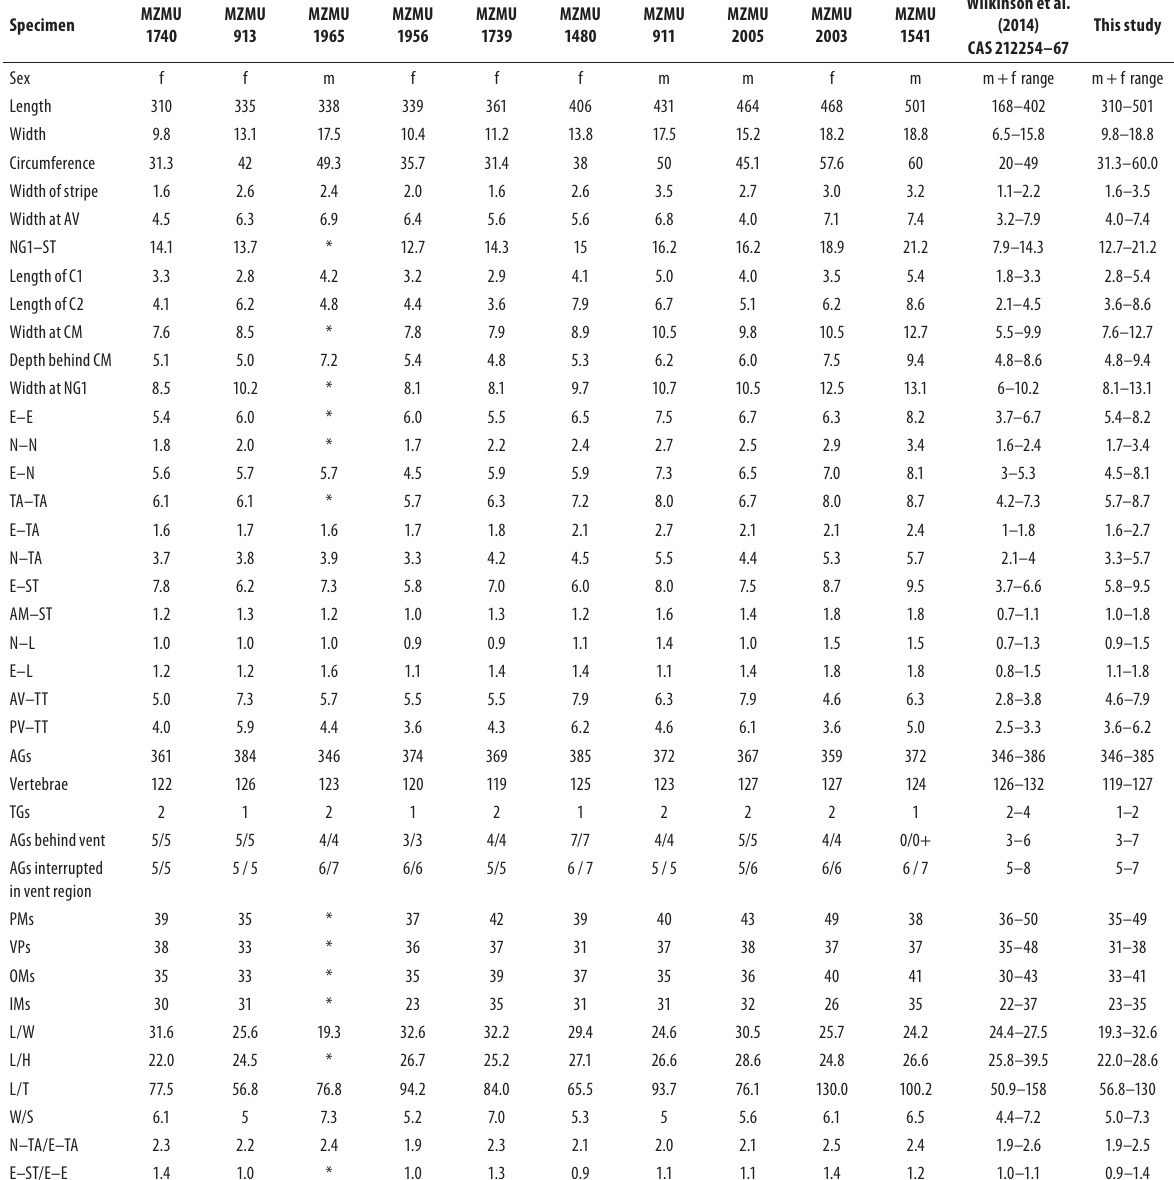
Table 1. Morphometric (in mm) and meristic data for the newly reported specimens of Ichthyophis multicolor from Mizoram and ranges for the type series from Wilkinson et al. (2014). Asterisk denotes damaged head on right side, and plus (+) denotes anomalous character. Counts made on left and right are given in L / R order. See Methods for